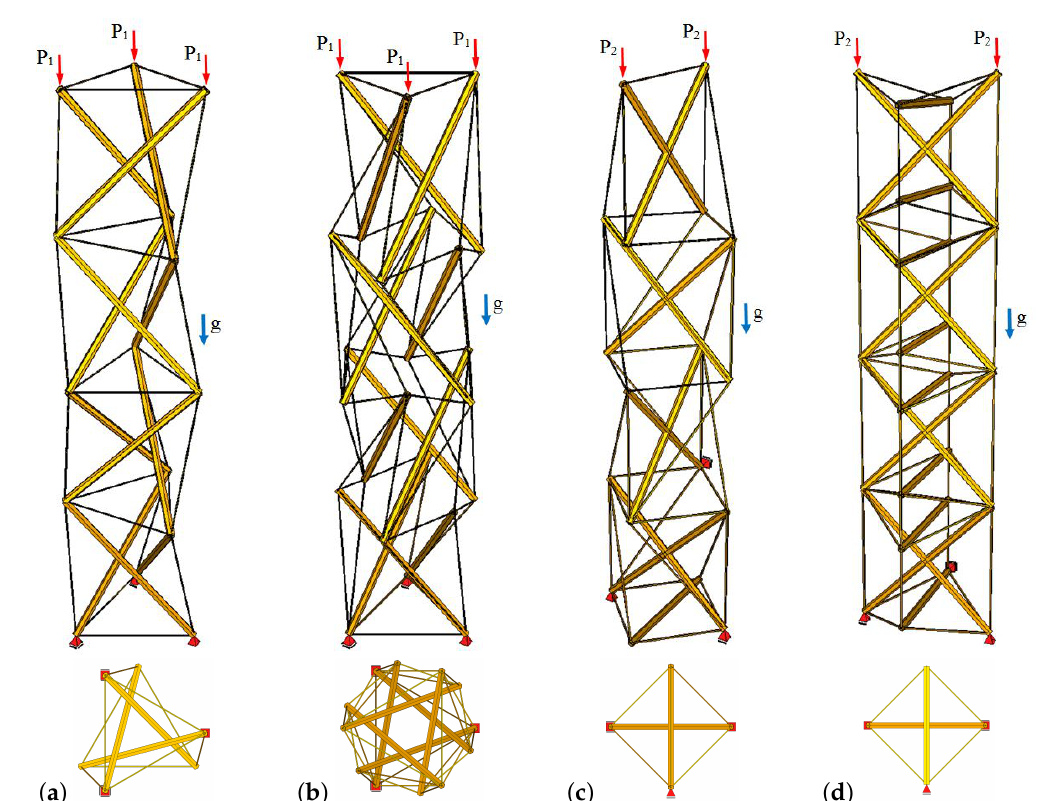
Figure 2. Tensegrity columns: ( a ) Simplex. ( b ) Overlapped simplex. ( c ) X. ( d )